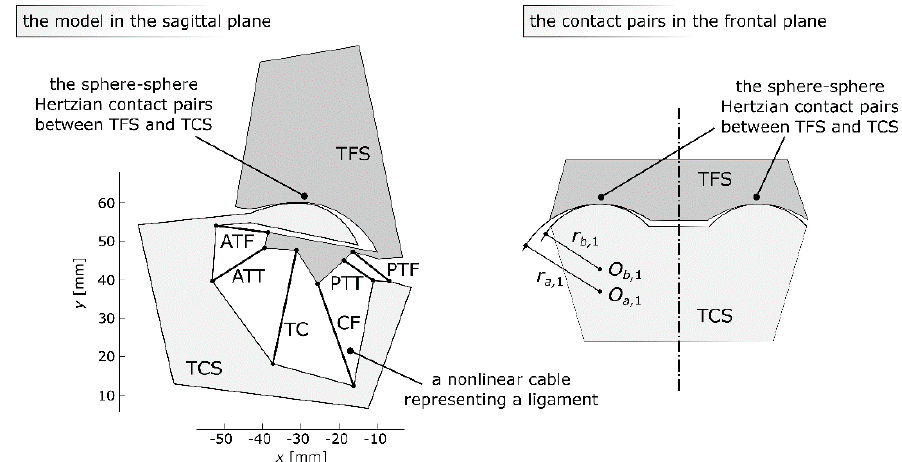
Figure 1. Theproposedplanarmodeloftheanklejointinthesagittalplaneandaschematicrepresentationofits spherical contact pairs in the frontal plane. TFS, basis-tibia-fibula segment; TCS, moving body-talus-calcaneus segment; ATT, anterior tibiotalar ligament; TC, tibiocalcaneal ligament; PTT, posterior tibiotalar ligament; ATF, anterior talofibular ligament; CF, calcaneofibular ligament; PTF, posterior talofibular